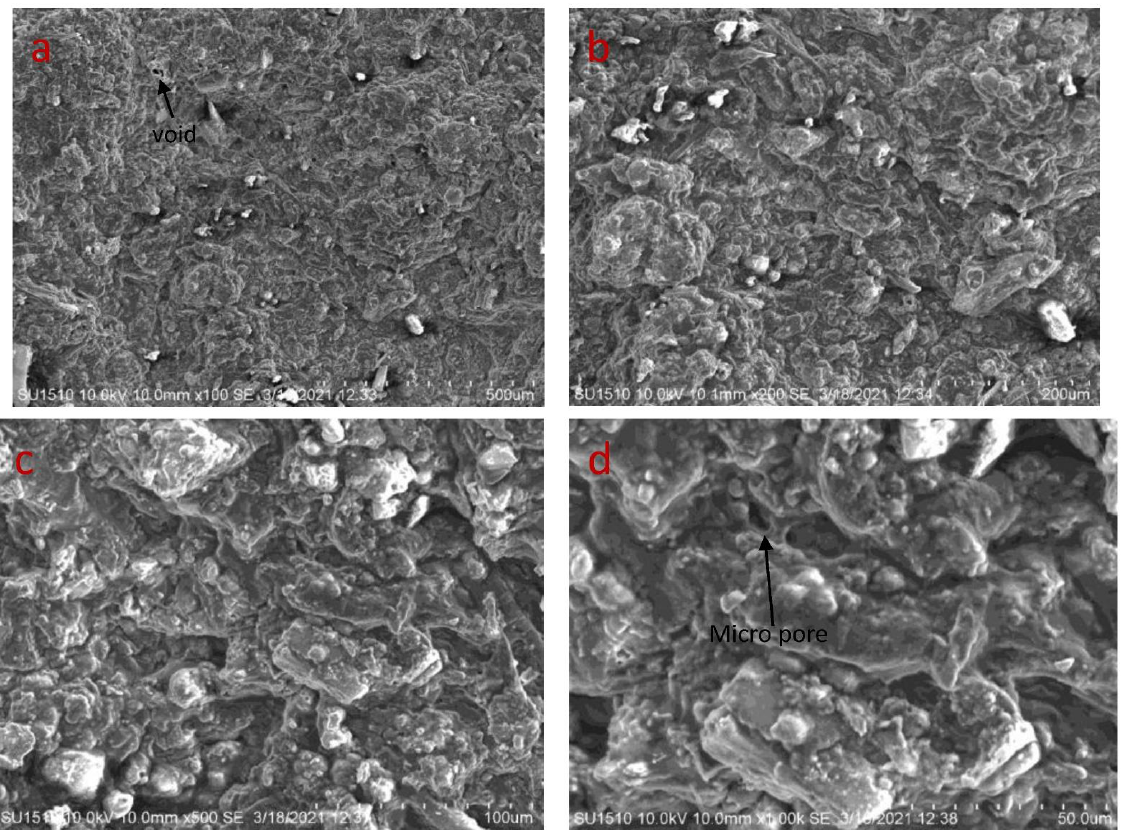
Figure 10. SEM images of 15% fenugreek bio-composite at ( a ) 500 µm ( b ) 200 µm ( c ) 100 µm ( d ) 50 µm.